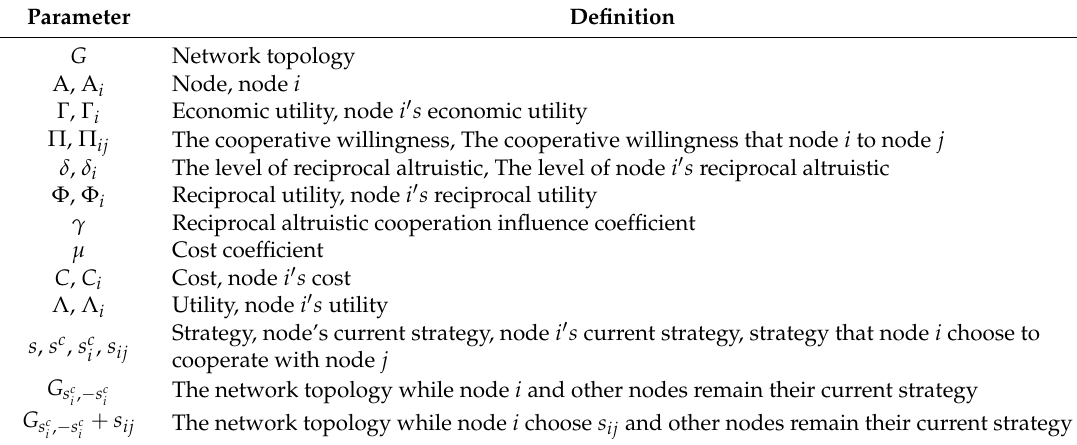
Table 2. The Notion used in Behavior Economics-based Message Transmission Cooperation Guarantee Mechanism